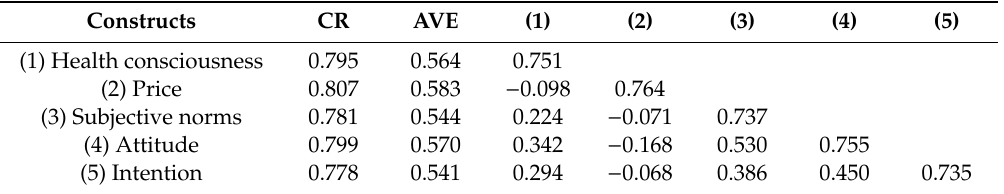
Table 3. Correlations, Composite Reliability (CR), and Average Variance Extracted